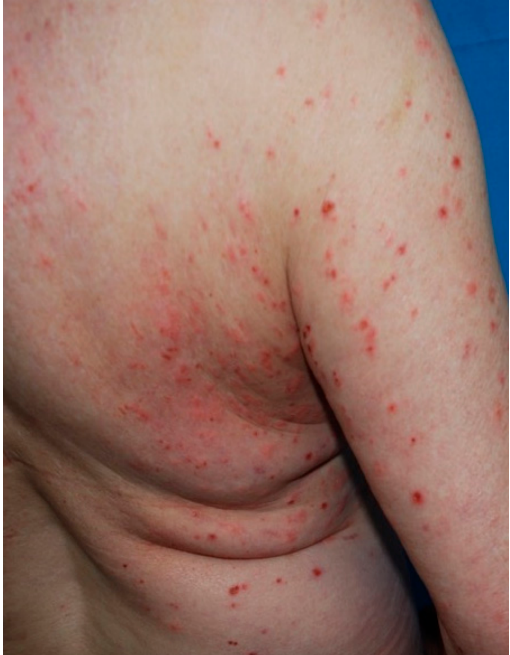
Figure 10. Multiple urticarial and excoriated papules due to insect bite reactions.